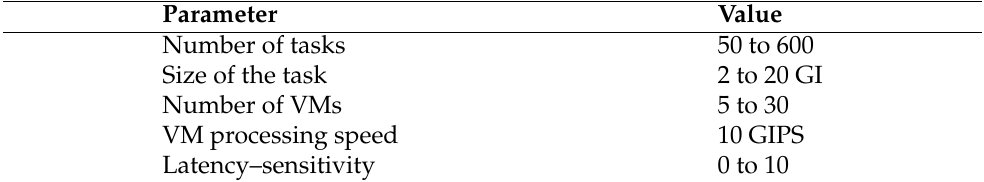
Table 1. Simulation